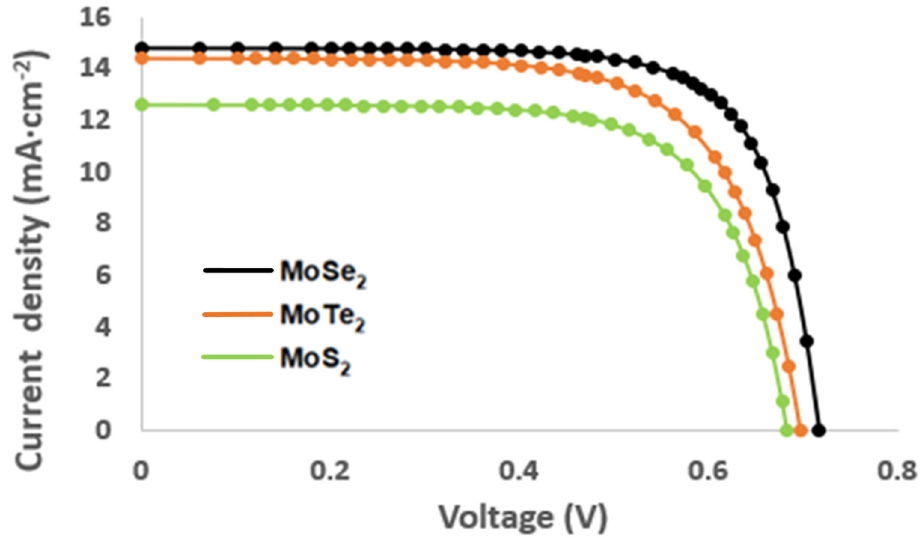
Figure 6. Current–voltage characteristic of the MoX 2 (X = S, Se, Te) nanoparticles